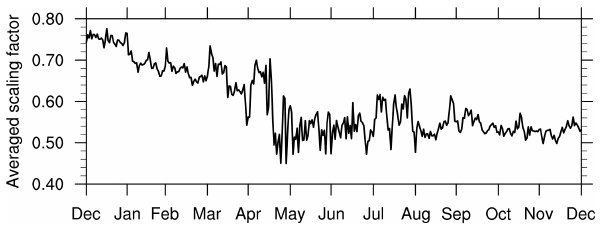
Figure 6. Time series of the averaged scaling factors from 1 January to 31 December 2010.